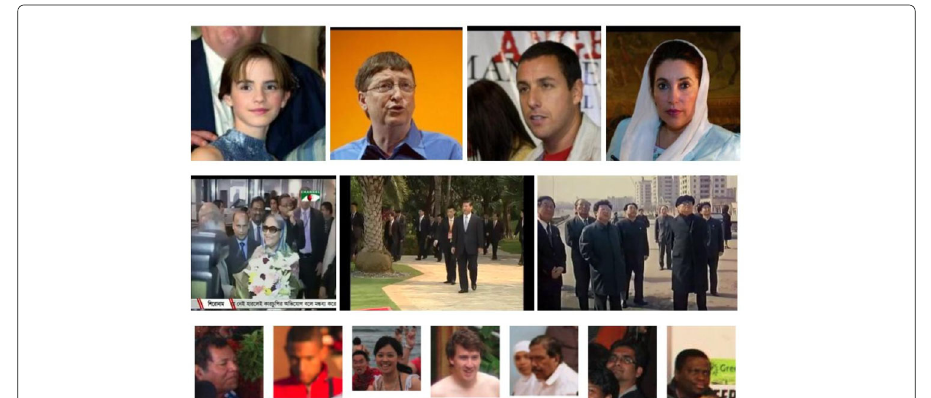
Fig. 8 Sample data in three benchmarks LFW (top), video frames from IJB-A (middle) and MegaFace